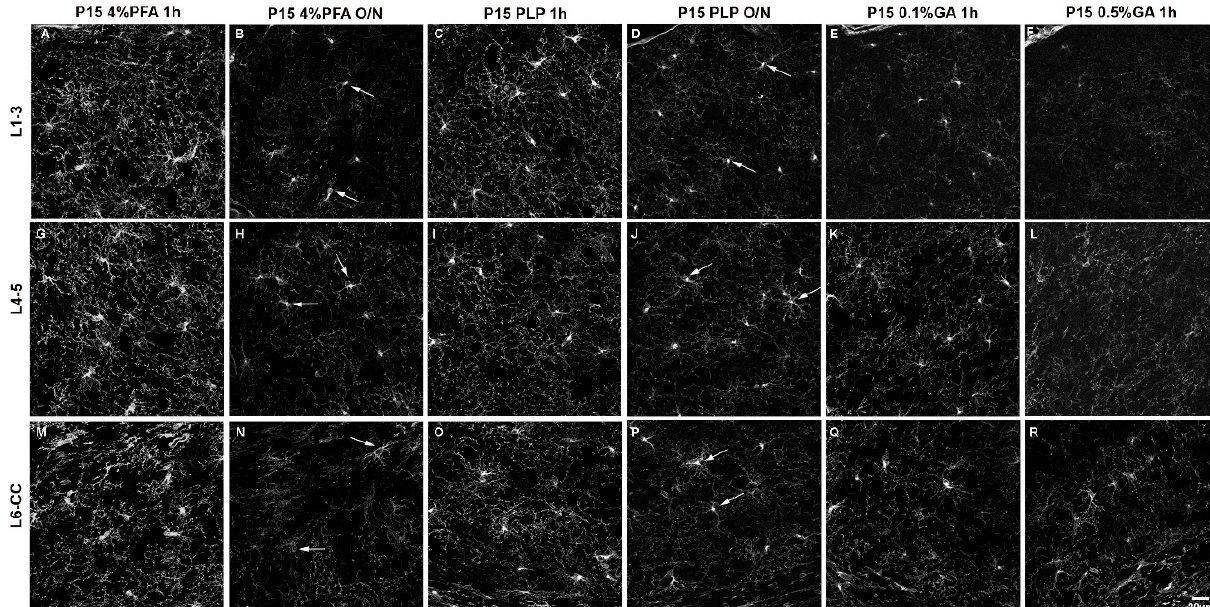
Figure 1. The effects of different fixation protocols on PDGFR α immunofluorescence at P15. ( A – F ): cortical layers 1–3, ( G – L ): cortical layers 4/5, ( M – R ): cortical layer 6/corpus callosum. P15 4%PFA 1 h ( A , G , M ) results in the strongest signal, comparable to P15 PLP 1 h ( C , I , O ). In P15 4%PFA O/N ( B , H , N ), P15 PLP O/N ( D , J , P ), P15 0.1%GA 1 h ( E , K , Q ) or P15 0.5%GA 1 h ( F , L , R ) the PDGFR α signal is decreased. Arrows indicate PDGFR α -positive OPC cell bodies that are still detectable after O/N fixation. Scale bar represents 20 µm.